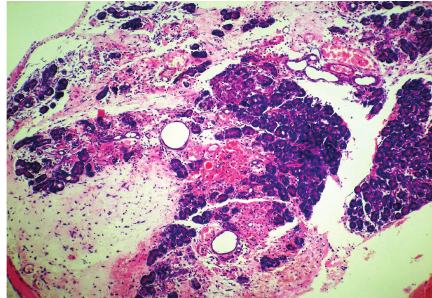
Figure 8: Histopathologic sections of pancreas (HE, x100), C: EEN group. The pancreas of EEN group also showed moderate reduction in necrosis, edema, and inflammatory cells infiltration as compared with those in control group. EEN: early enteral nutrition.